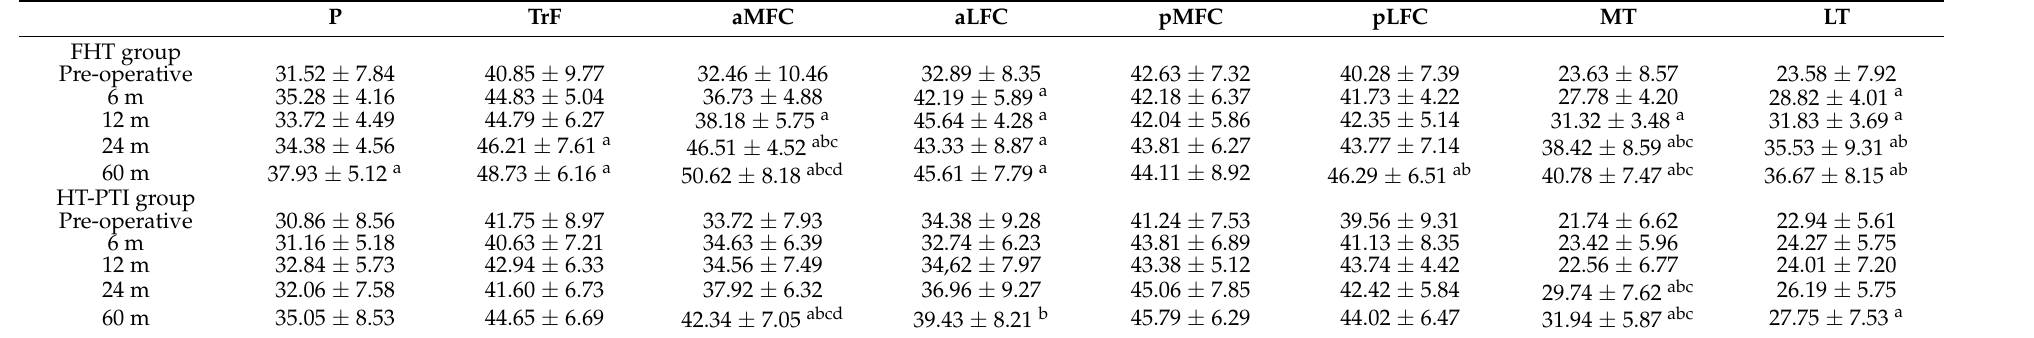
Table 2. T2 values at Different Subregions and Timepoints in Two Groups α .